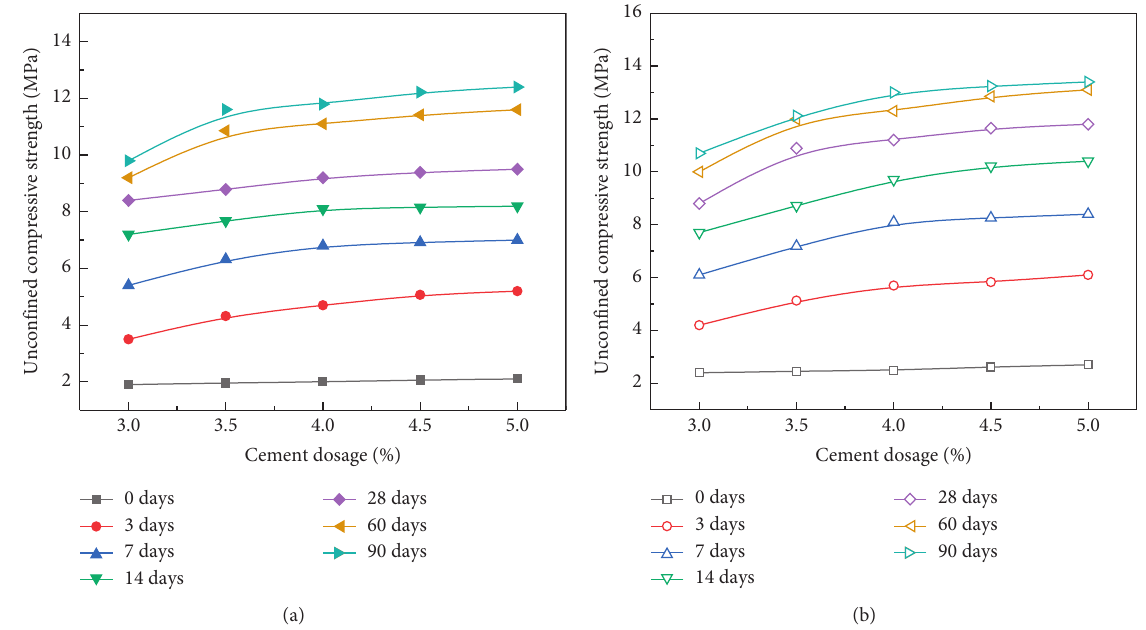
Figure 4: Effect of cement dosage on unconfined compressive strength. (a) GM gradation; (b) XM gradation.